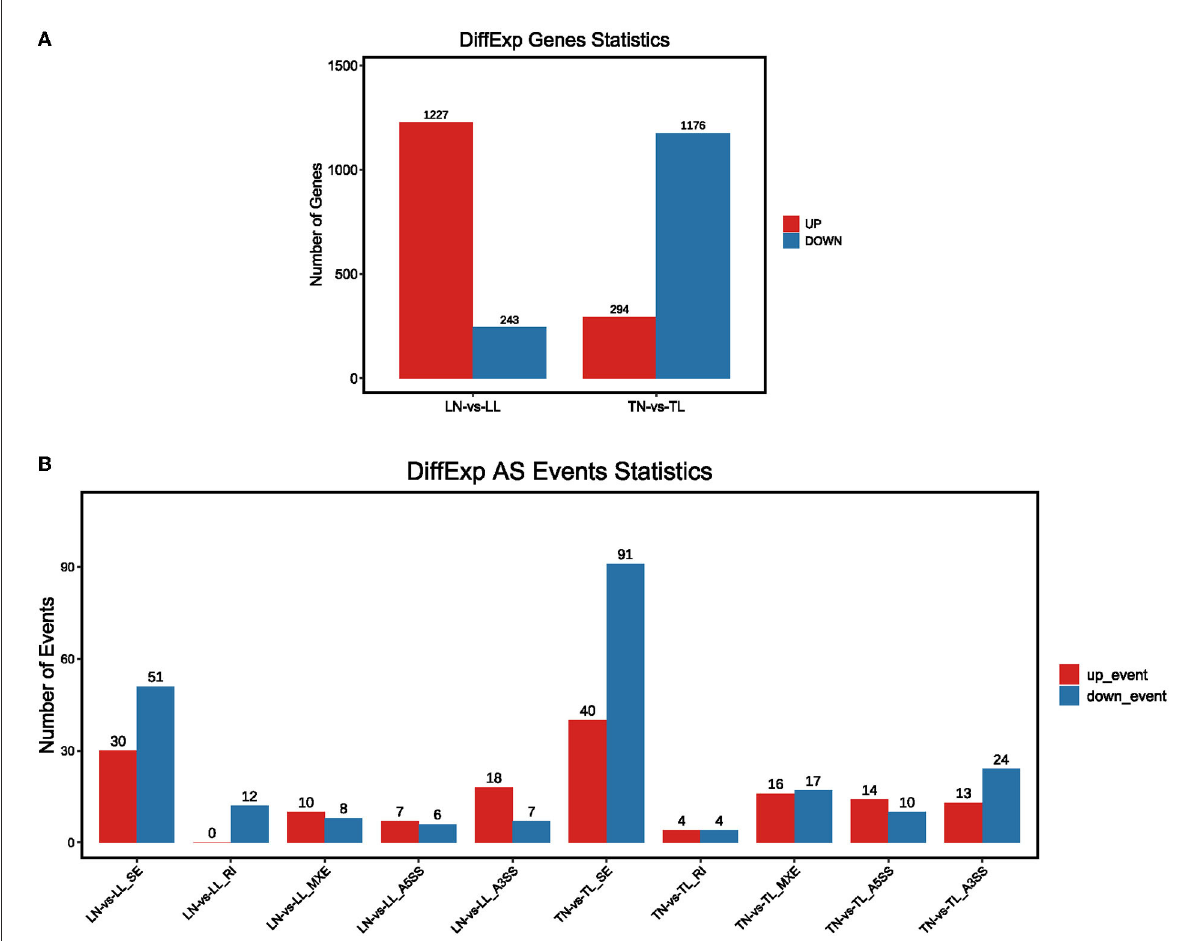
FIGURE3 The presence of alternate spliced DEGs in the cross region of normoxic and hypoxic groups. (A) DEGs with alternate splicing were distributed in Tibetan pigs and landrace pigs in normoxia and hypoxia groups; (B) Distribution of DEGs with alternate splicing in five splicing events of Tibetan pigs and Landrace pigs in normoxia and hypoxia groups,